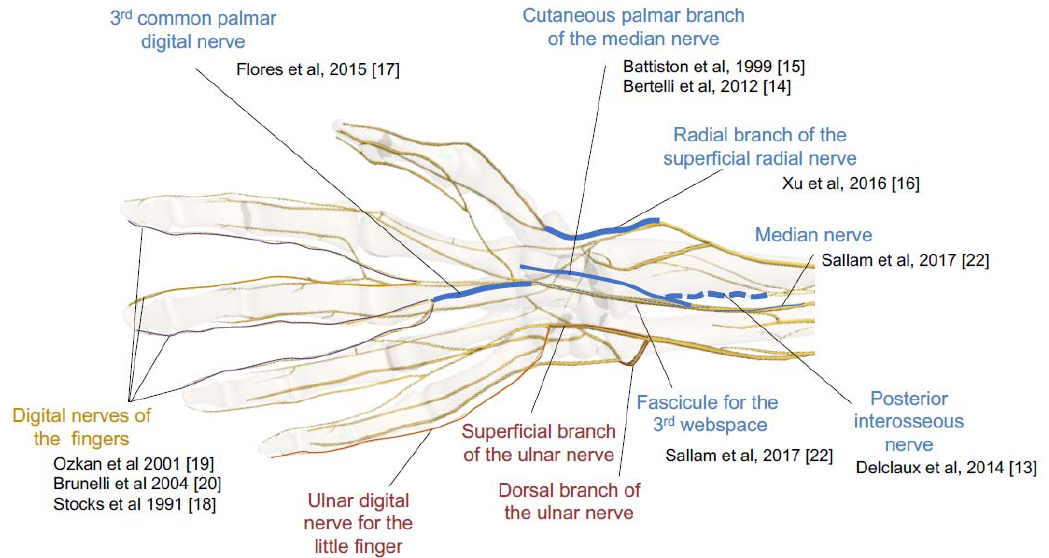
Figure 2. Summary of the ten surgical strategies. In blue: donor nerves. In red: recipient nerves at the wrist level. In yellow: recipient nerves at the hand level [13–20,22]. (Image created using ZygoteBody Professional™ zygotebody.com).